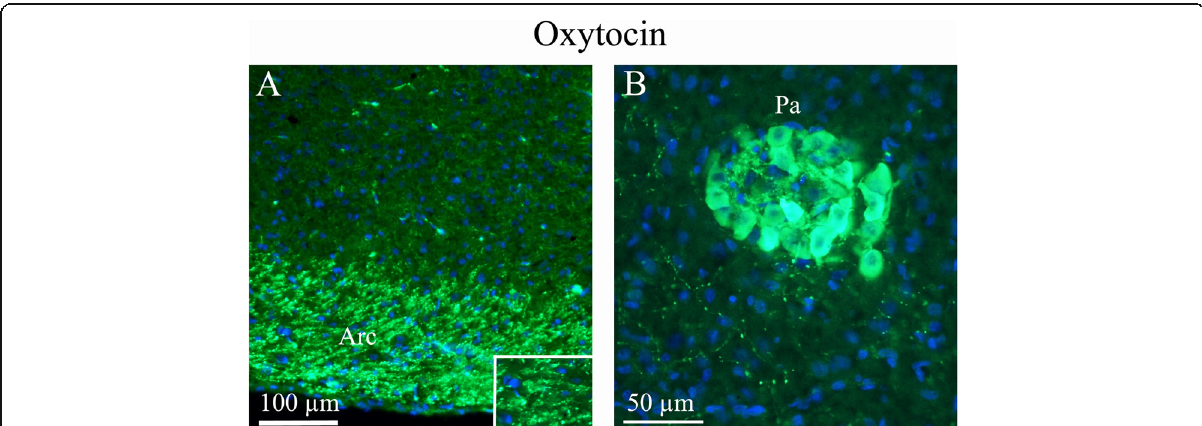
Fig. 3 Oxytocin immunohistochemistry of the paraventricular hypothalamic nucleus and the arcuate nucleus. a . The Arcuate nucleus (Arc), that